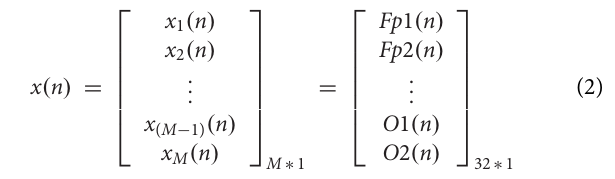
Frontiers in Human Neuroscience |